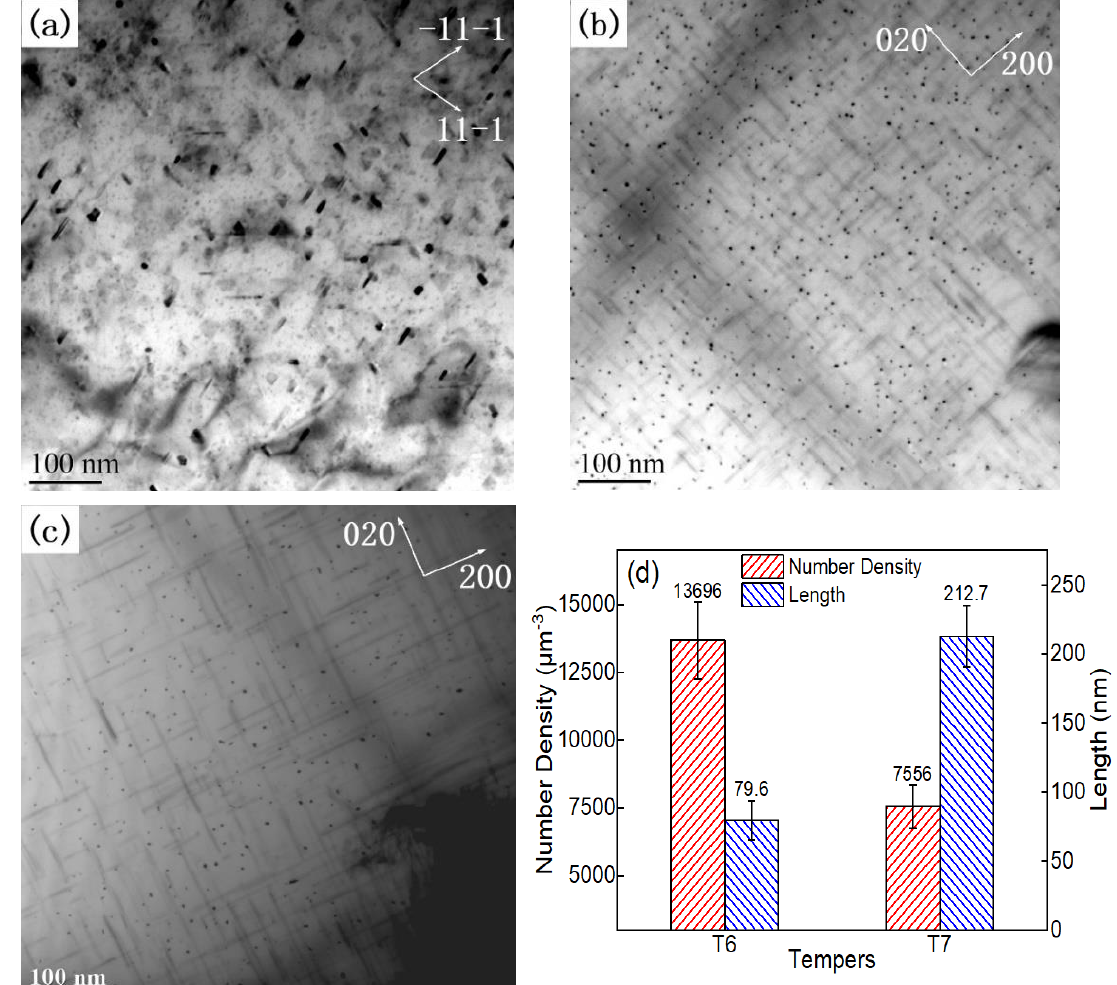
Figure 5. Precipitation after: ( a ) T5, ( b ) T6, and ( c ) T7, and their characteristics after T6 and T7 ( d ).